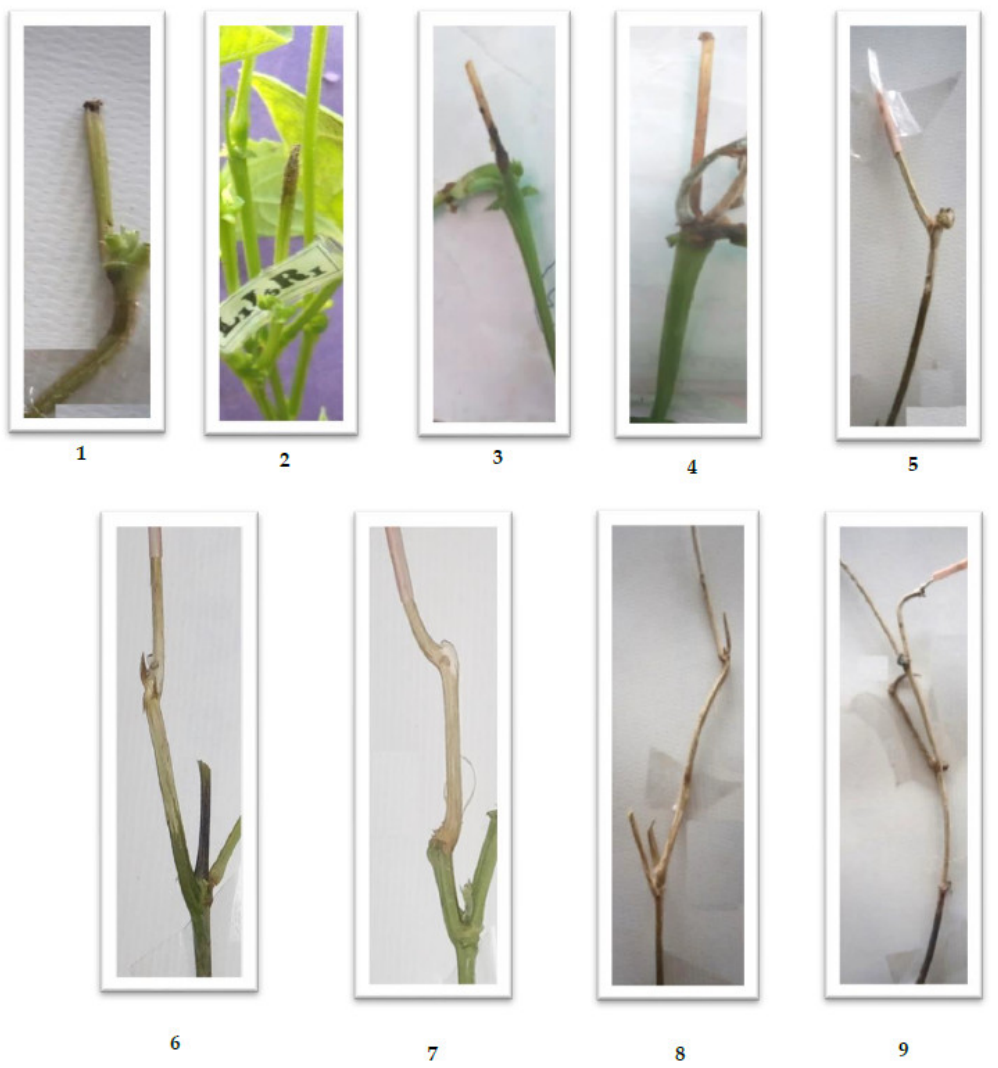
Figure 5. Disease scoring scale; 1–9 represents respective disease scores (Teran et al., 2006) [21]. Table 6. Disease reaction of six isolates of S. sclerotiorum on eighteen bean genotypes.